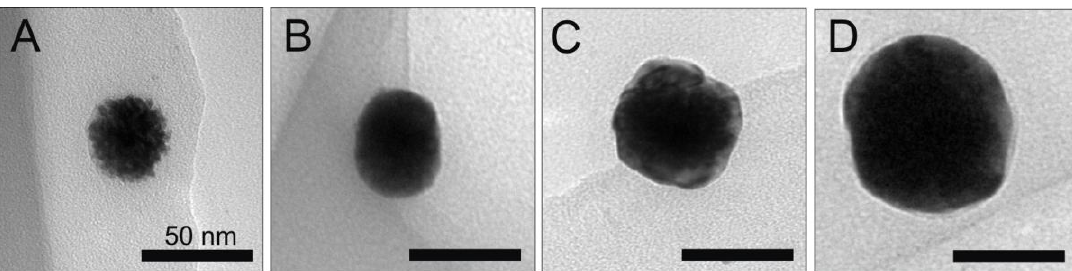
Figure 2. TEM images of a platinum core particle (39.8 nm) ( A ) and Pt@Ag particles with an optimal silver shell thickness of 1.3 ( B ); 5.2 ( C ); and 9.1 ( D )